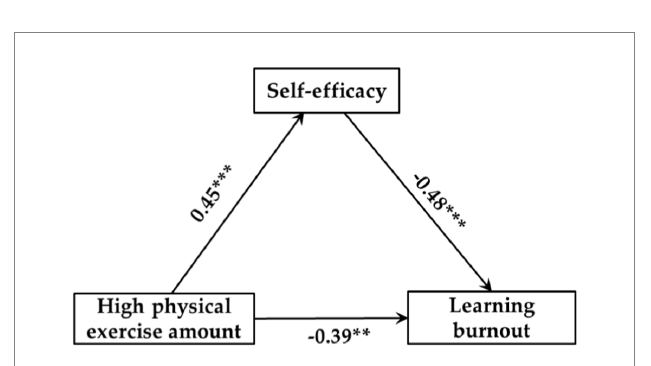
FIGURE 4 Mediating model of self-efficacy between high exercise amount